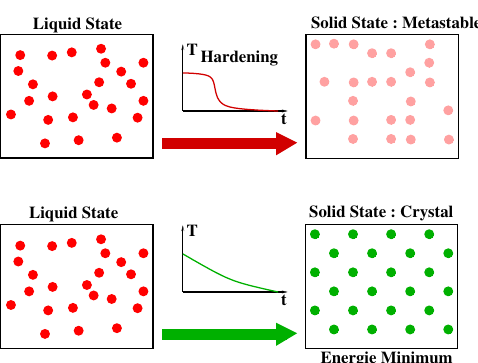
Figure 2. When the temperature is high, the material is in a liquid state ( left ). For a hardening process, the material reaches a solid state with nonminimal energy (metastable state; top right ). In this case, the structure of the atoms has no symmetry. During a slow annealing process, the material also reaches a solid state, but one in which the atoms are organized with symmetry (crystal; bottom right